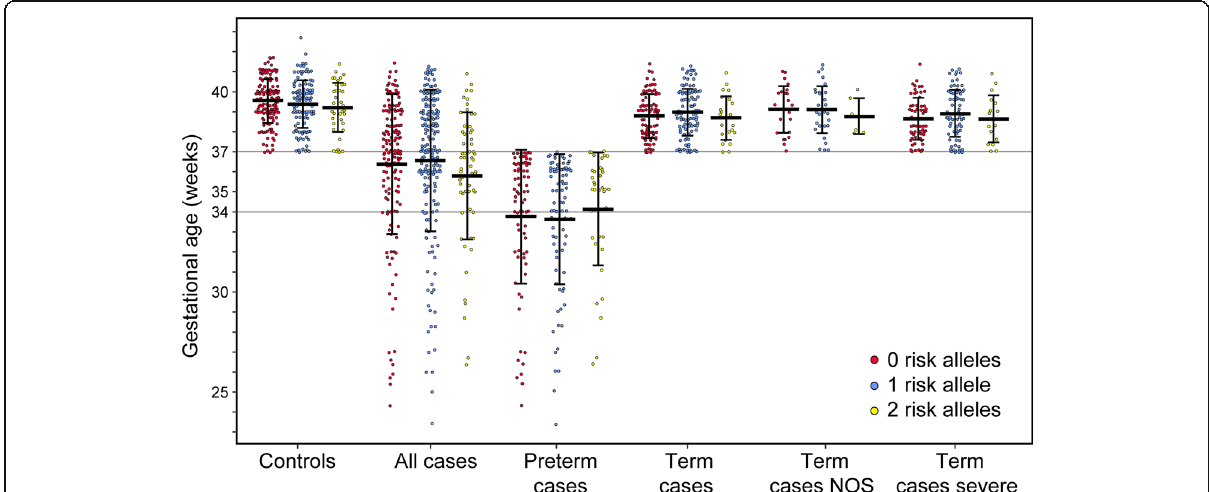
Fig. 1 No difference in gestational age based on APOL1 genotype. Preterm was defined as less than 37 weeks gestation, and early onset PE is before 34 weeks gestation. Although our cohort only recorded time of delivery and not onset of PE symptoms, all deliveries prior to 34 weeks would be from early onset PE. Controls versus all cases and preterm cases were significantly different ( P <0.001), but there was no difference in gestation age within each case definition by APOL1 genotype. Data are